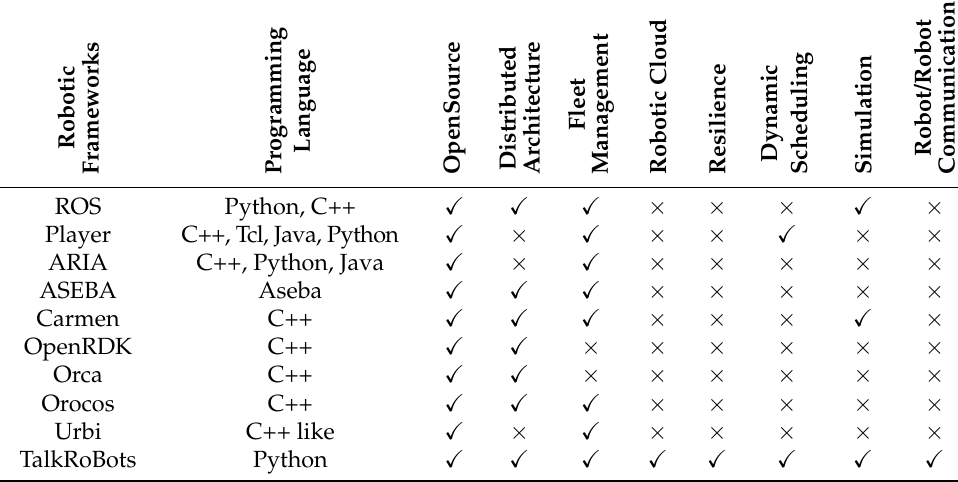
Table 1. Frameworks/middleware comparison ( × not implemented/designed for; (cid:88) fulfilled).